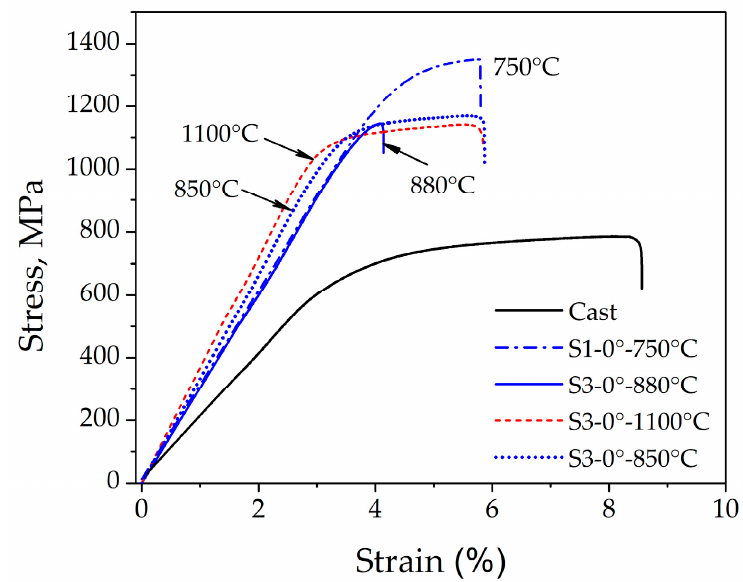
Figure 6. Stress–strain curves of Co–Cr alloy specimens from the C and S groups.